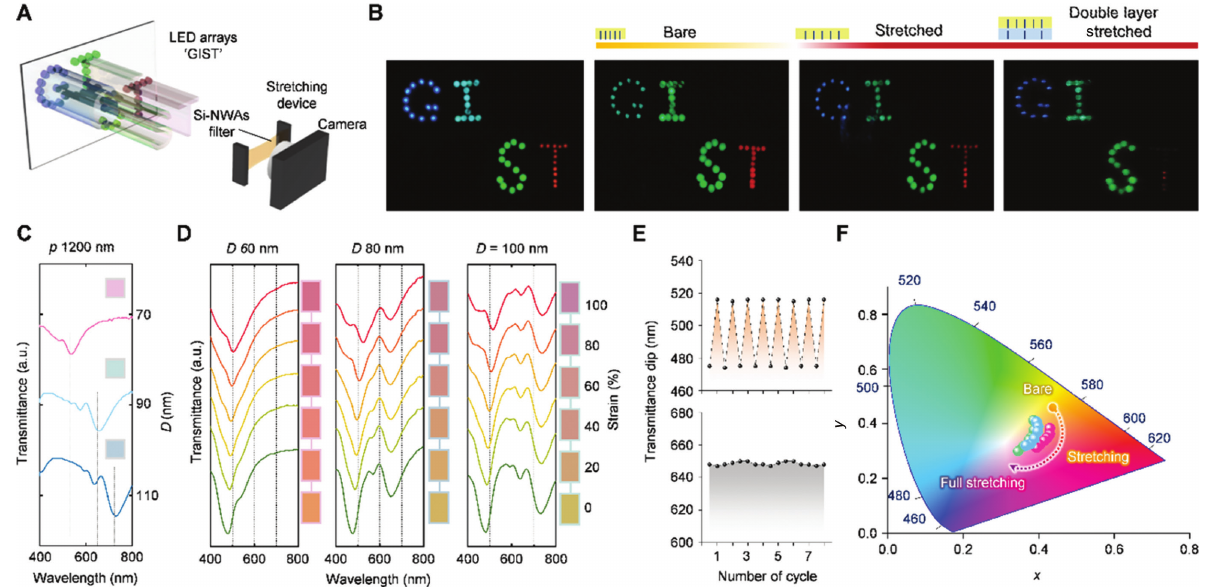
Figure 4: The optical filtering features and strain-induced spectral tunability. (A) Schematic illustration of the experimental setups for optical filters. (B) Photographs of “GIST” lettered LED arrays and optical filter experimental results. (C, D) The transmittance of the Si-NWAs and color representation depending on the strain ratio. (E) Transmittance dip after the strain cycle of the Si-NWAs with periods of 600 nm (top) and 1200 nm (bottom). (F) Color coordinates for the double-layered